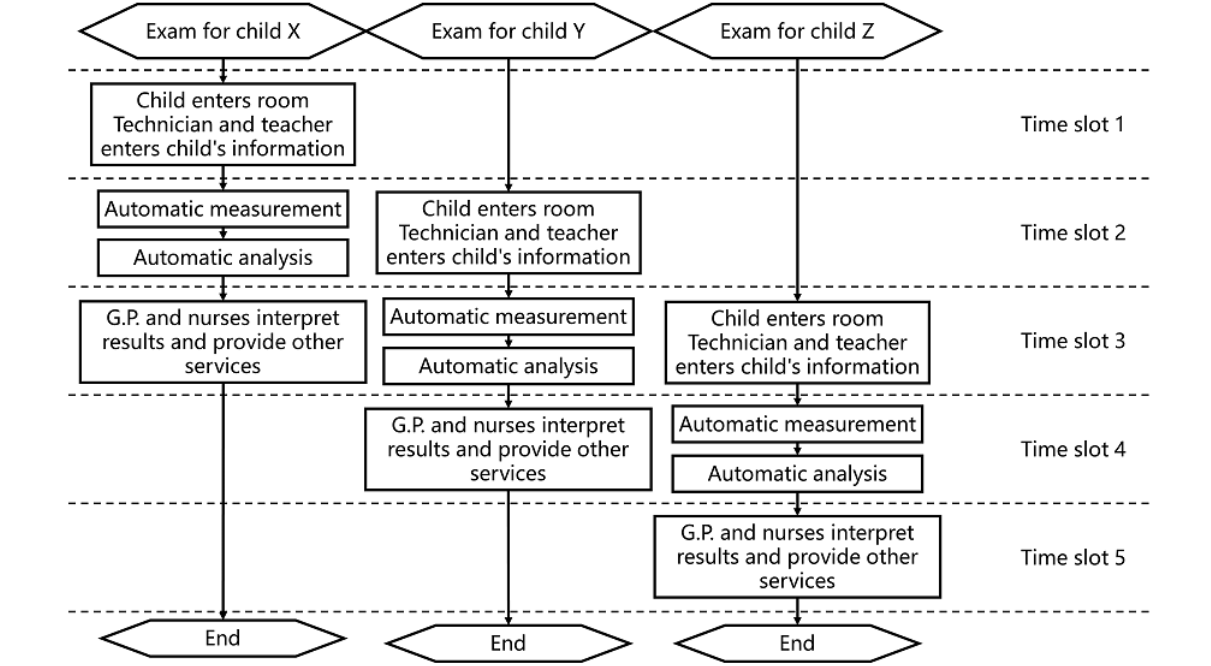
Figure 8. Streamlined workflow for 3 children. G.P.: general